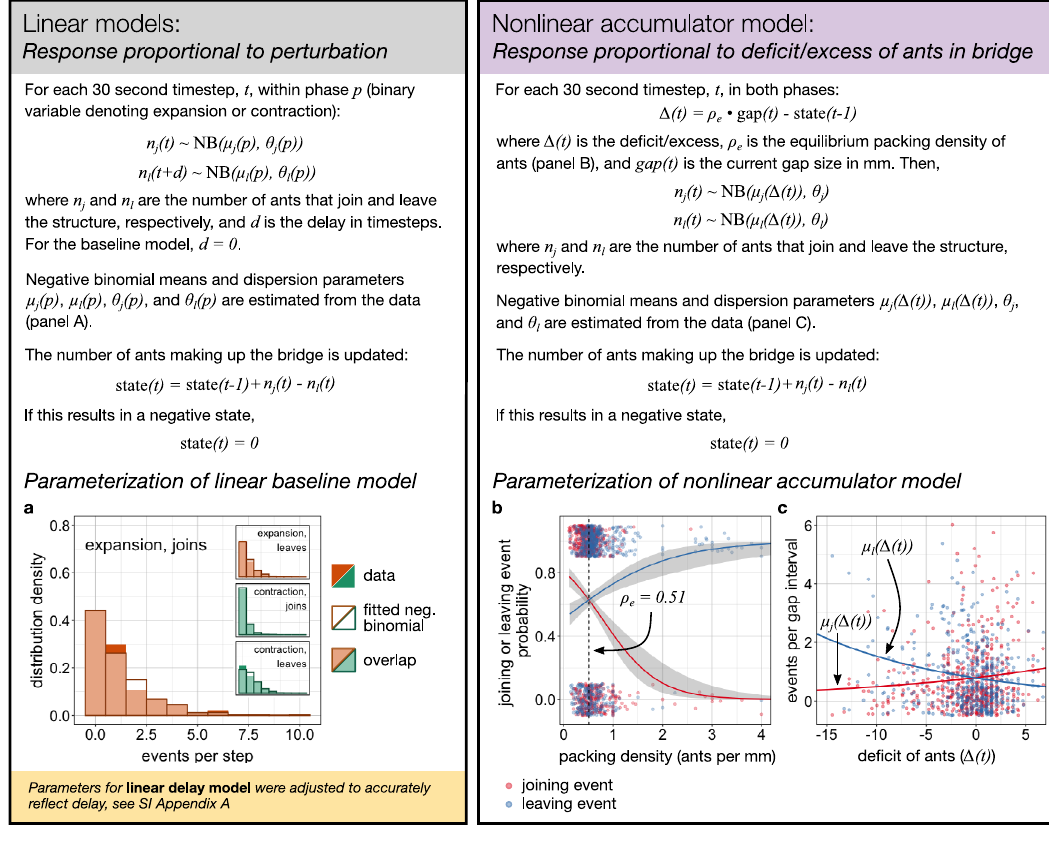
Fig. 3 Mechanistic model descriptions. Model descriptions with equations are shown at the top. a Distributions of the number of ants joining or leaving self-assembled bridge structures per 30 s gap interval, measured separately during gap-size expansion and contraction phases, shown respectively in orange and green, and negative binomial distributions fi tted to these data. Main panel: distribution of joining events in the expansion phase. Inset panels show expansion leaving events and all events in the contraction phase. b Probability of joining (pink) and leaving (blue) at different packing densities (number of ants/gap size), determined with logistic regression. Gray bands show 95% con fi dence intervals. The equilibrium packing density, where the joining probability is equal to the leaving probability, is 0.51 (dashed vertical line). Dots show joining (pink) or leaving (blue) events (at 1), or gap intervals with no such events (at 0). c Number of joining and leaving events in each gap interval across de fi cit values, where the de fi cit is the equilibrium number of ants minus the actual number of ants in the bridge. Thick lines show negative binomial regressions fi tted to these